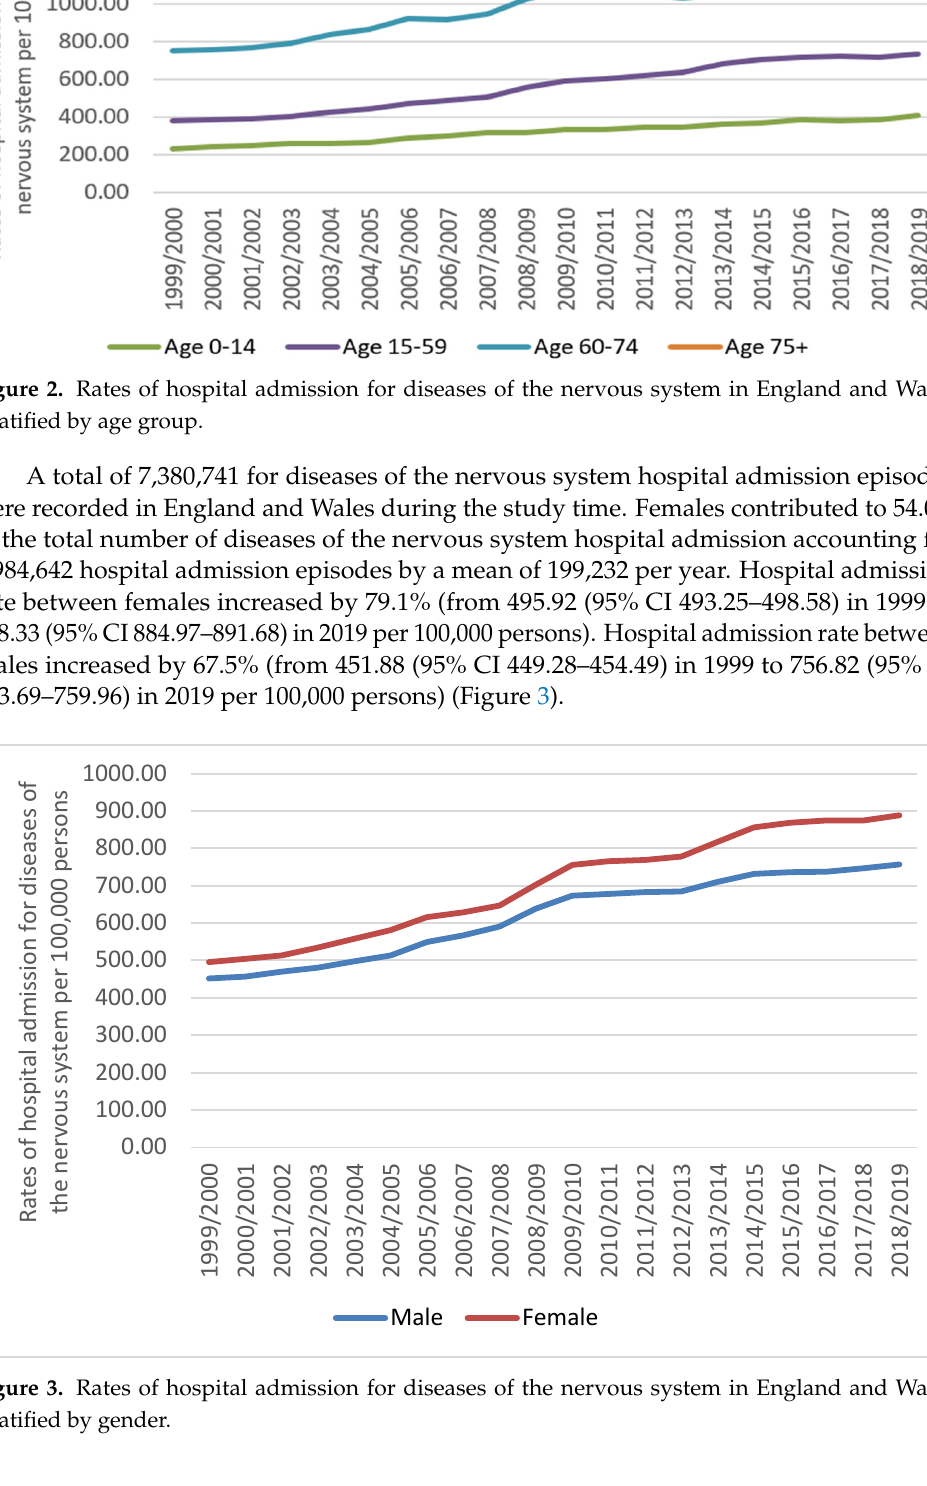
Figure 3. Rates of hospital admission for diseases of the nervous system in England and Wales stratified by gender.